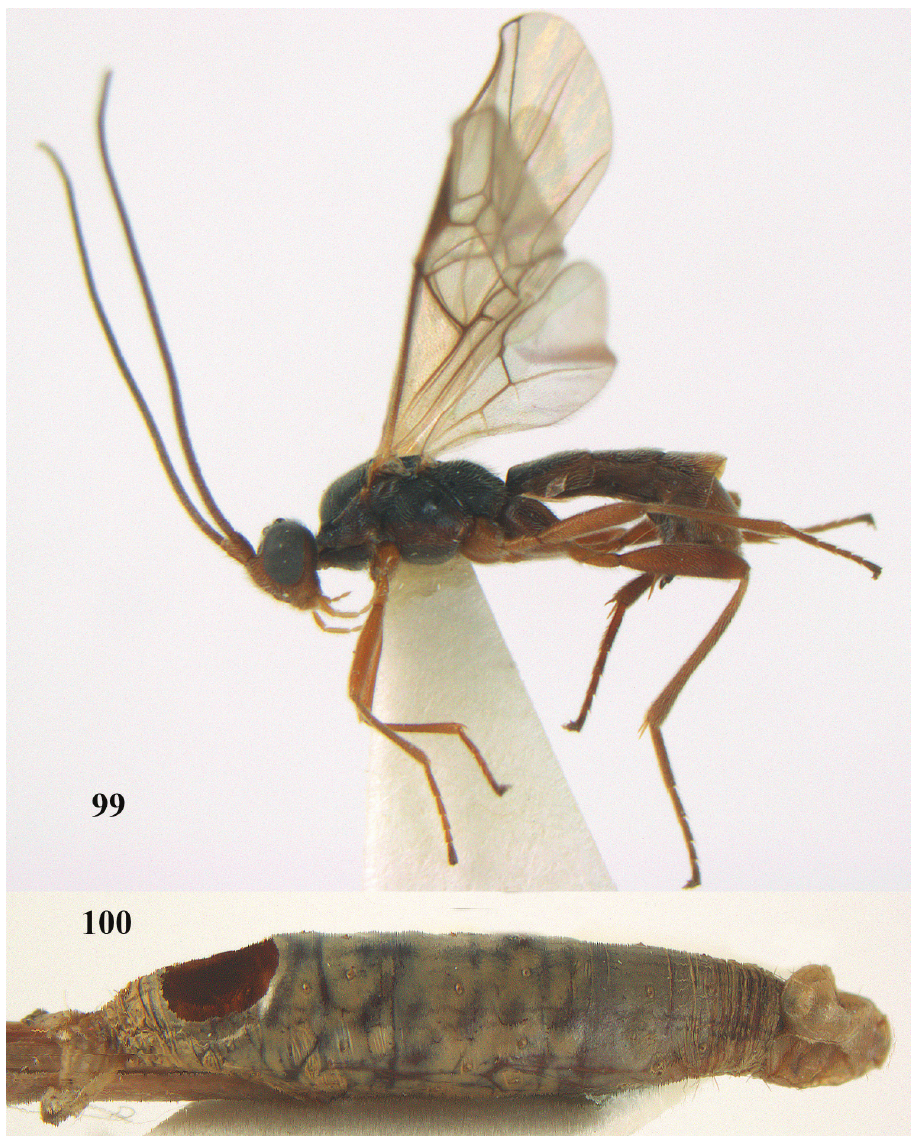
posteriorly; mesosternum rather angulate posteriorly; scutellum finely coriaceous and non-carinate laterally; dorsal face of propodeum medium-sized, convex and rugulose, but posteriorly with some carinae and smooth in between and anteriorly mainly granu- late, median carina complete, without tubercles. Wings. Fore wing: r 0.5 × 3-SR (Fig. 101); 1-CU1 horizontal, 0.4 × as long as 2-CU1; r-m 0.7 × 2-SR, and 0.4 × 3-SR; second submarginal cell elongate (Fig.